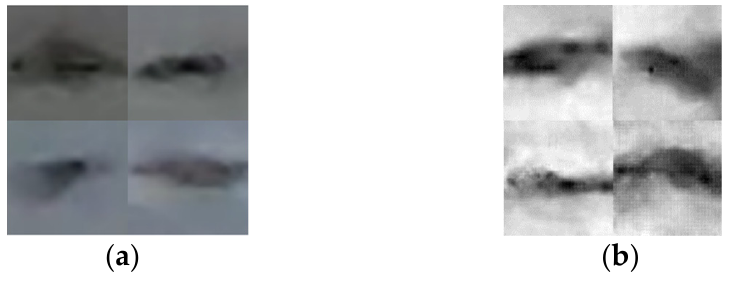
Figure 3. Comparison between DCGAN-generated scratch samples and original samples. ( a ) Real scratch samples. ( b ) Scratch samples generated by DCGAN. scratch samples. ( b ) Scratch samples generated by DCGAN.